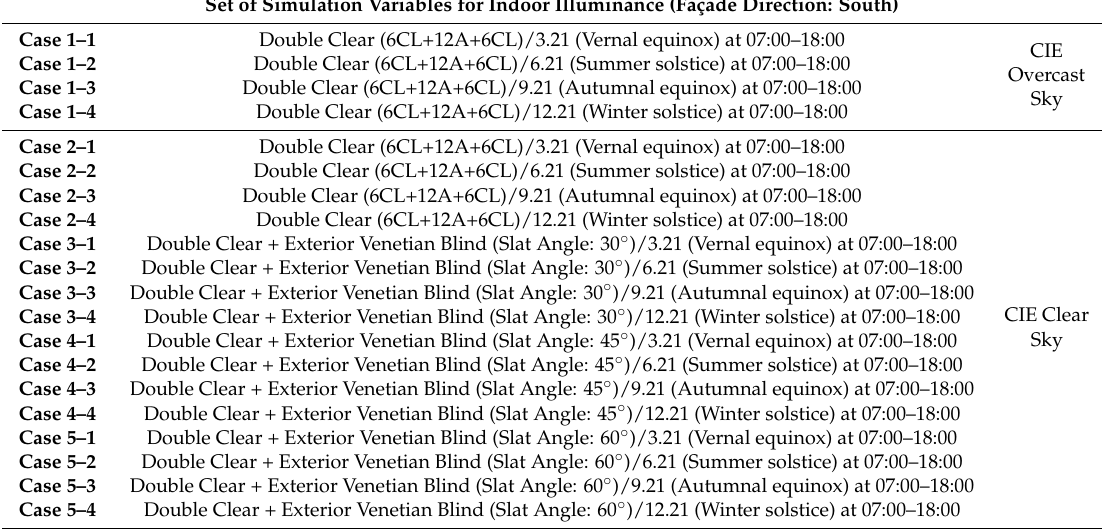
Table 5. Set of simulation variables for indoor illuminance.